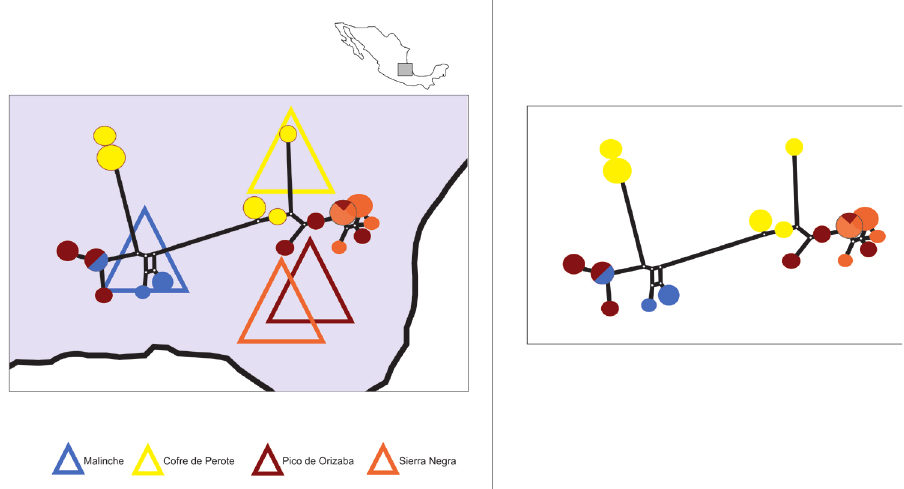
Figure 5. The size of the circles is proportional to the haplotype frequency. The length of links between haplotypes is proportional to the number of mutated positions. The median vectors that represent hypo- thetical intermediates or unsampled haplotypes are shown in small open dots. The haplotype circles’ color corresponds to the sampling origin (one color per